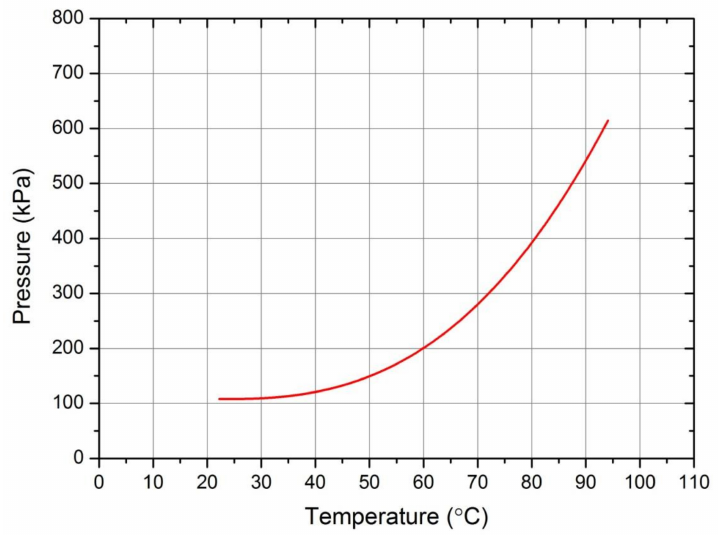
Figure 2. Equilibrium pressure of AC with respect to the temperature measured in a closed cham- ber [9]. Reprinted with permission from ref. [9]. Copyright 2021 Elsevier.